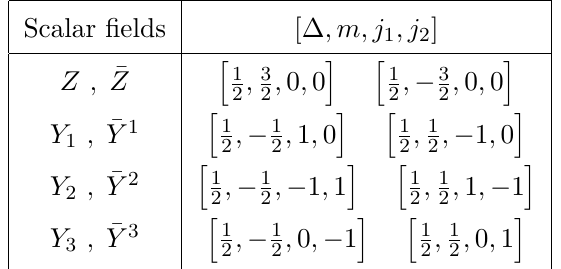
Table 1 . Table of Dynkin labels of fermionic generators. For a generic element v µ transforming in a weight- µ representation, the Dynkin label corresponding to a generator H is defined as j ( v ) ≡ 2[ H ] . i µ i , v µ